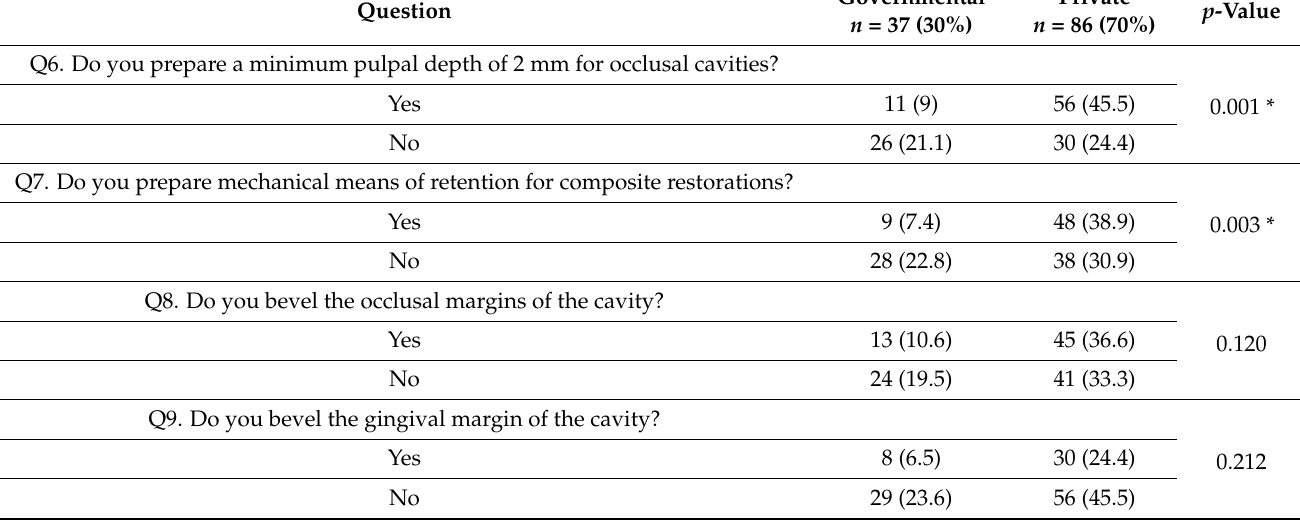
Table 3. Comparison between DP working in the governmental and private sectors with regard to the specifications of cavity preparation for posterior composite